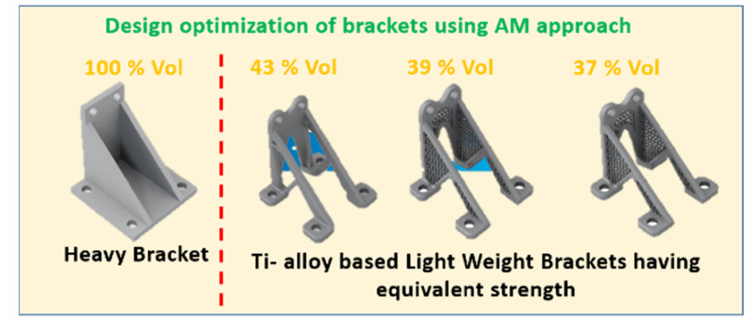
Figure 4. Schematic of Ti-alloy bracket processed by AM